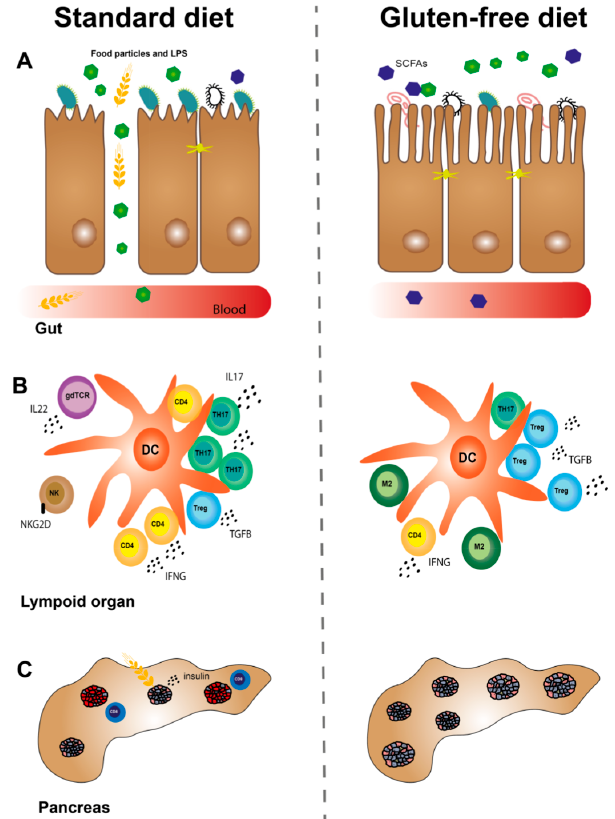
Figure 1. Gluten free (GF) diet and the development of type 1 diabetes (T1D)—a hypothesis. ( A ) A GF diet decreases the intestinal permeability and increases the villus-to-crypt (V:C) ratio,